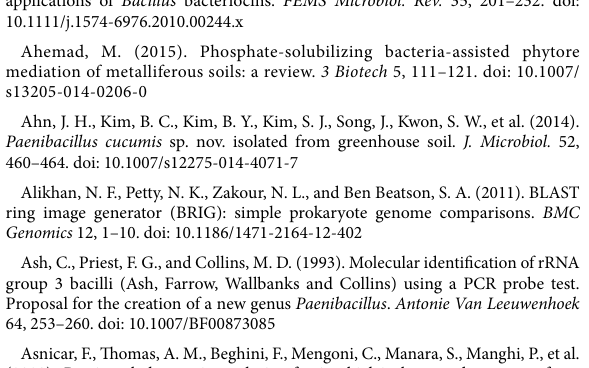
SUPPLEMENTARY FIGURE 4 (A) Phylogenetic tree for P. peoriae ZBSF16 and the genus Paenibacillus based on 16S rRNA ( Bacillus velezensis FZB42 was used as an outgroup). (B) Phylogenetic tree of Paenibacillus peoriae ZBSF16 among other Paenibacillus species. The phylogenetic tree was constructed based on five housekeeping genes (16S rRNA, gyrB , rpoD , rho , and pgk ) according to the aligned gene sequences using the maximum likelihood method in MEGA 6.0. Bootstrap values (1,000 replicates) are shown at the branch points. The scale bar indicates 0.05 nucleotide substitutions per nucleotide position. GenBank accession numbers associated with the housekeeping loci of all strains can be found in Supplementary Table 1 . SUPPLEMENTARY FIGURE 5 ANI (A) and DDH (B) value matrix heatmap between Paenibacillus peoriae ZBSF16 and six other Paenibacillus genome sequences. SUPPLEMENTARY FIGURE 6 Venn diagram showing the number of clusters of orthologous genes shared and unique